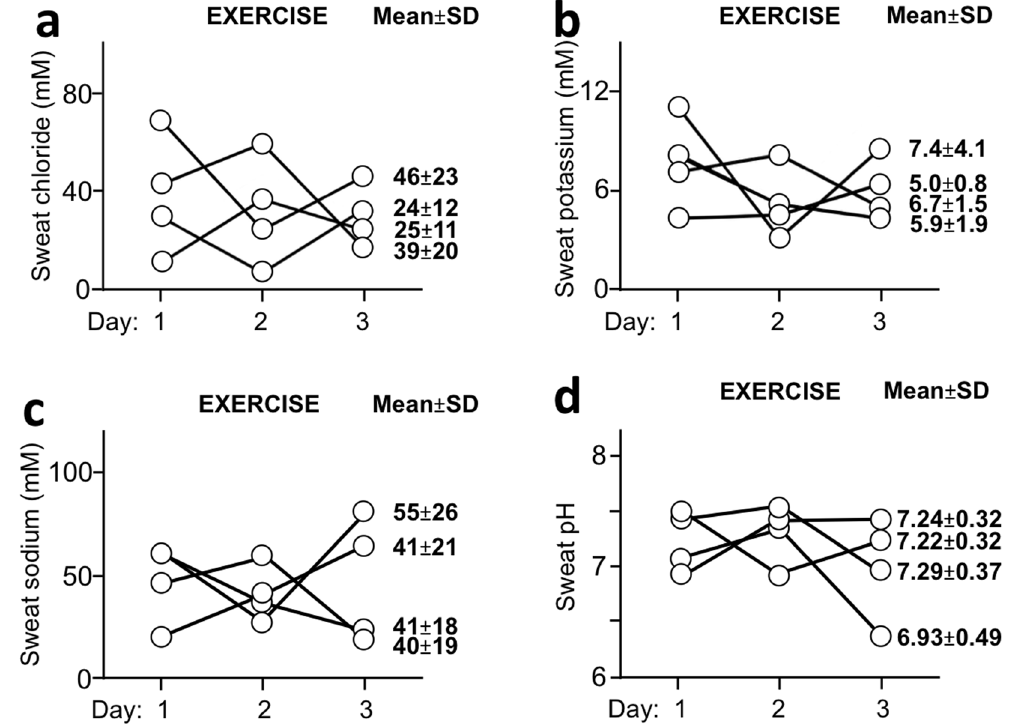
Figure 3. Measurement repeatability of various parameters in sweat produced following cycling exercise. We investigated the measurement repeatability of various parameters by measuring electrolyte levels or pH in 4 healthy subjects for 3 days at 24hr-interval (level of chloride: ( a ) potassium: ( b ) sodium: ( c ) pH: ( d )). Mean ± SD data corresponding to the values obtained for 3 days for a given subject are